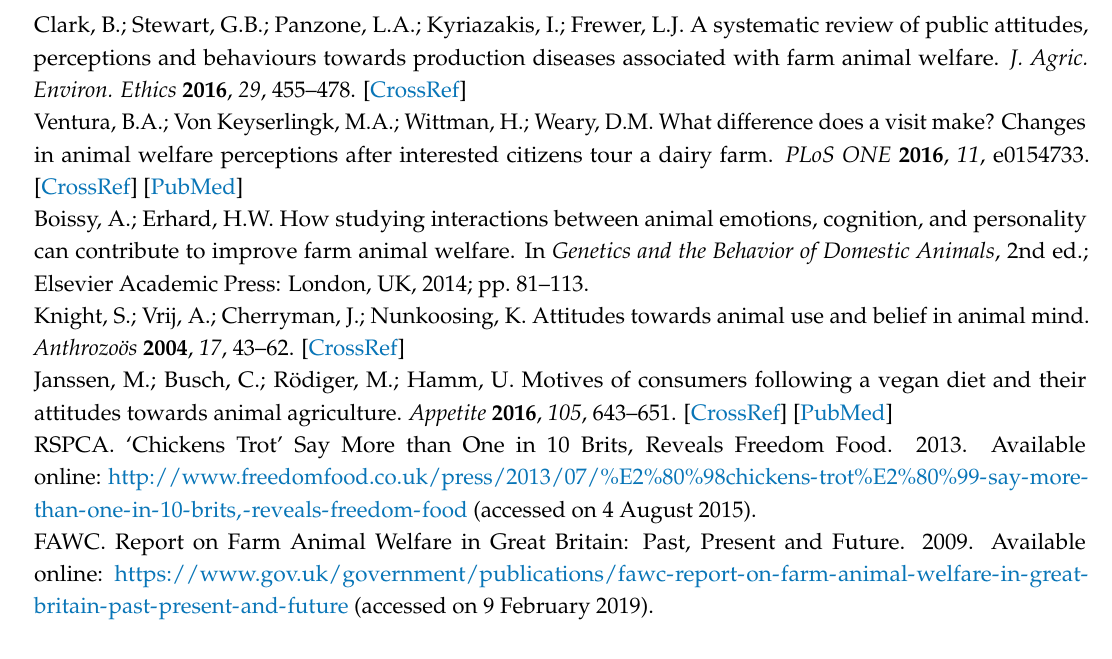
Figure S1: Screenshots of Farm Animal Welfare, Table S1: Full content and functionality of Farm Animal Welfare. Author Contributions: Conceptualization, R.D.H., J.M.W. and G.A.R.M.F.; Supervision of Farm Animal Welfare game development, J.M.W.; data collection and analysis, R.D.H.; writing—original draft preparation, R.D.H.; writing—review and editing, R.D.H. and J.M.W. Funding: This research received no external